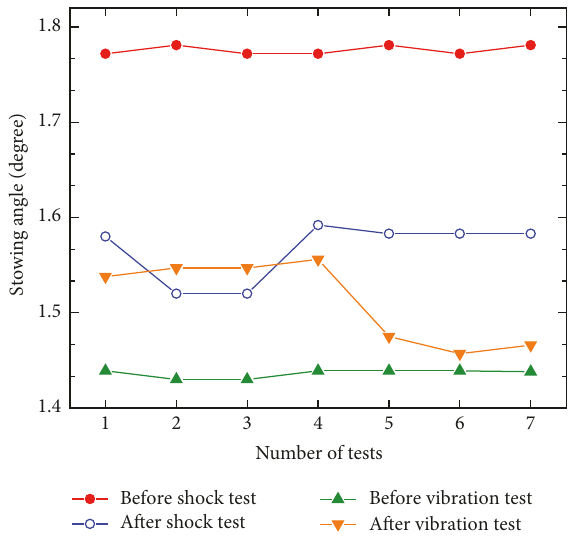
Figure 14: Measured stowing angle values before and after launch environment tests.